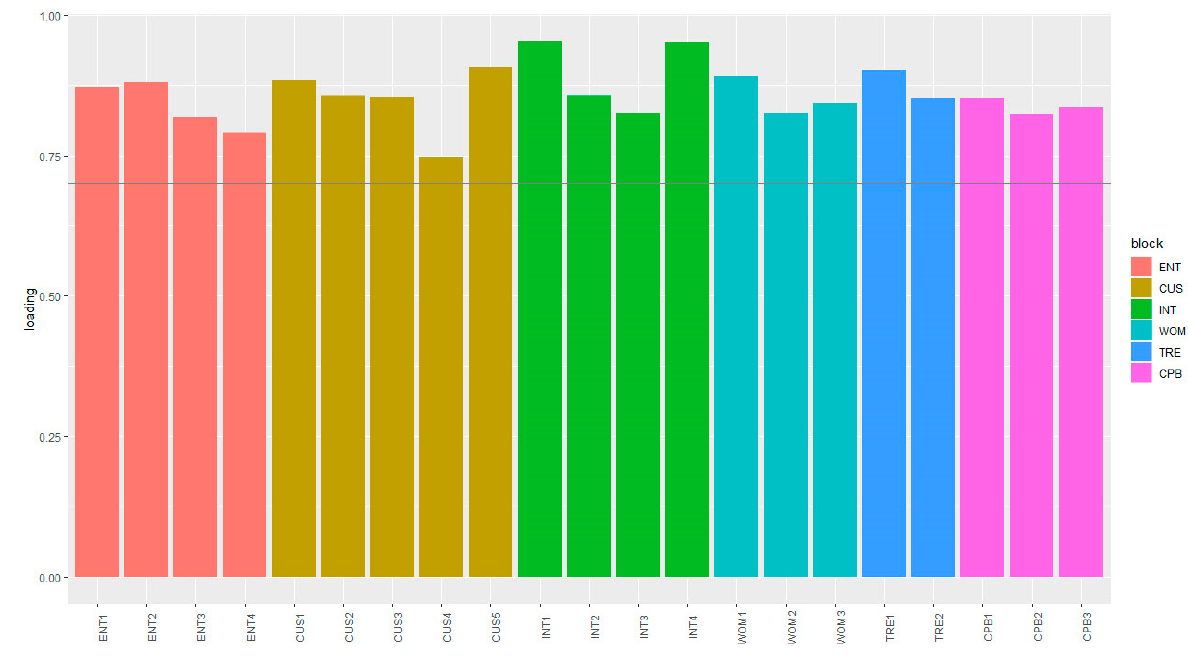
Figure 2. Graphical outer loadings scores with R.